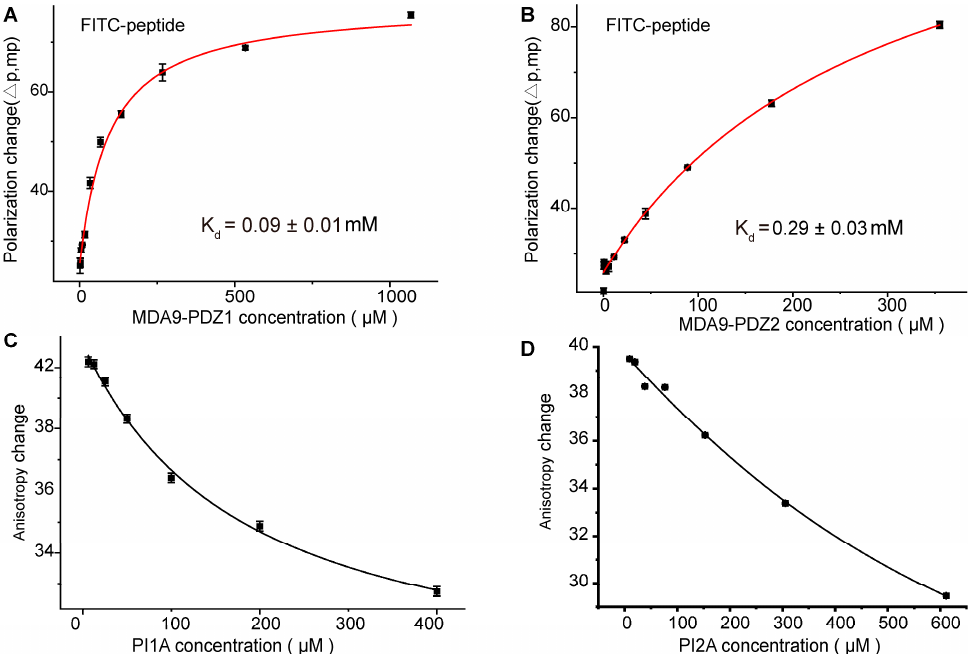
Figure 4. PI1A/PI2A blocking the binding between MDA-9 PDZ1/PDZ2 domain and their peptide substrate. ( A , B ) The binding affinities of MDA-9 PDZ1 or PDZ2 domain to the FITC-labeled peptide (TNEFYF) determined by fluorescence polarization experiments, respectively. Error bars represent the standard deviations estimated from three biological duplicates. ( C ) Displacement of FITC-labeled peptide from MDA-9 PDZ1 domain upon titration of PI1A. ( D ) Displacement of FITC-labeled peptide from MDA-9 PDZ2 domain upon titration of PI2A. The assay was performed by adding 50 µ L PI1A or PI2A at the indicated concentrations, respectively, to 150 µ L FITC-peptide/protein complex, incubating for 2 h, and measuring anisotropy changes. Errors are estimated from three biological duplicates.